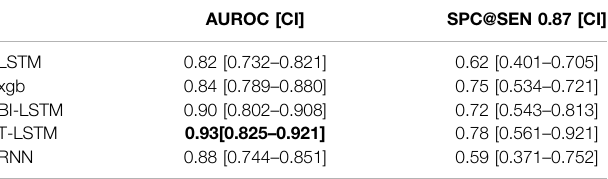
TABLE 5 | Results for all models, AUROC, and speci fi city at sensitivity (SPC@ SEN) of 0.87, with 95% con fi dence interval (CI) displayed in brackets.